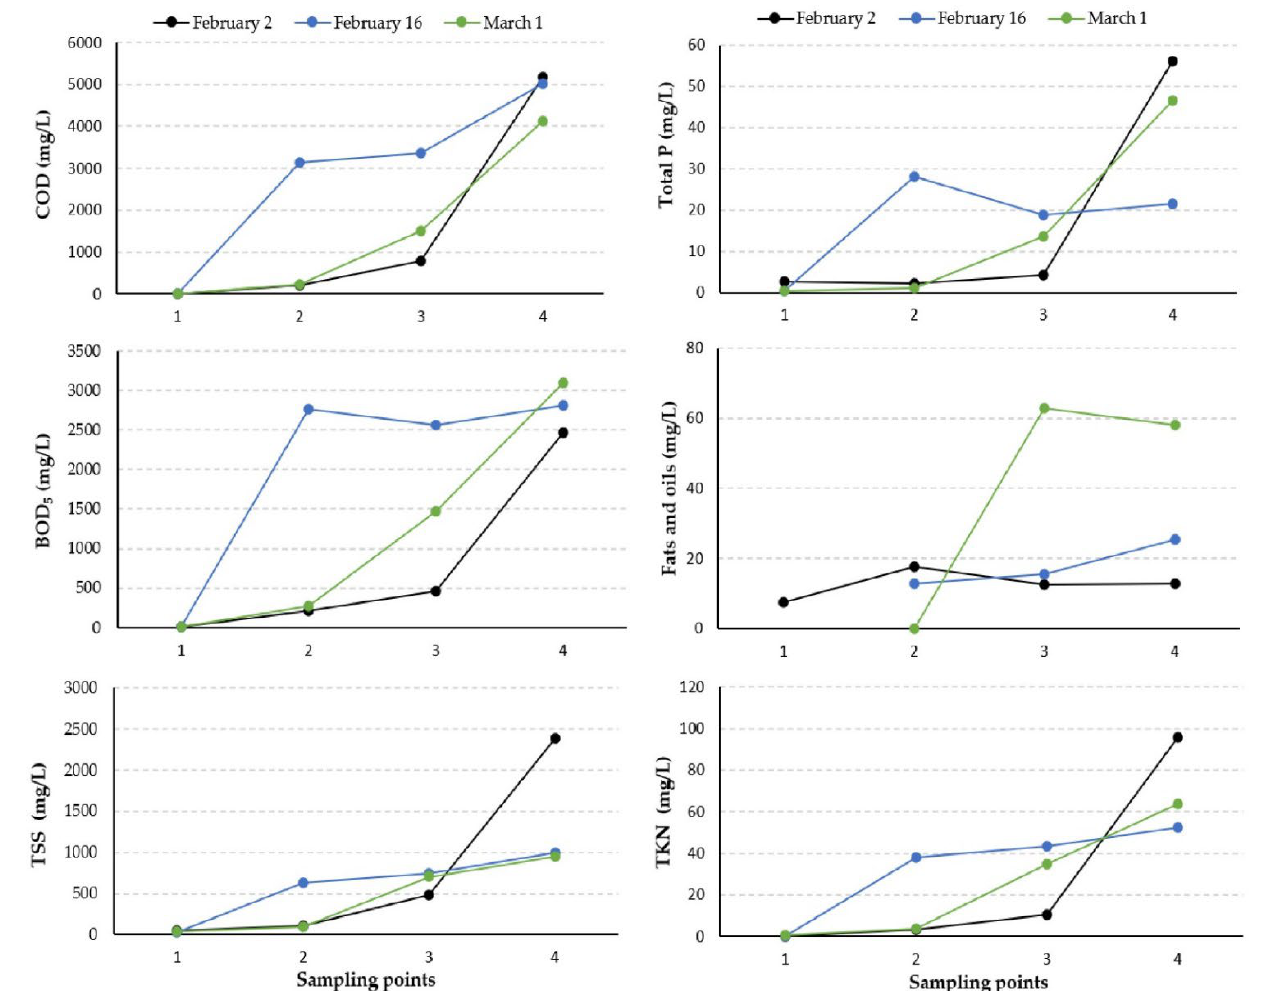
Figure 4. Concentrations of COD, BOD 5 , TSS, TKN, fats and oils, and phosphorus found in the Atizcoa stream during the three sampling campaigns.